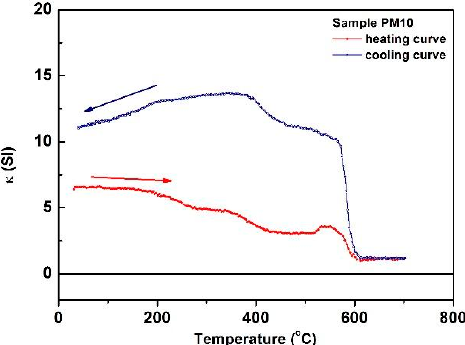
Figure 6. Thermomagnetic curves of magnetic susceptibility— κ (T) for PM10 collected in Warsaw: heating curve (red line) and cooling curve (blue line).